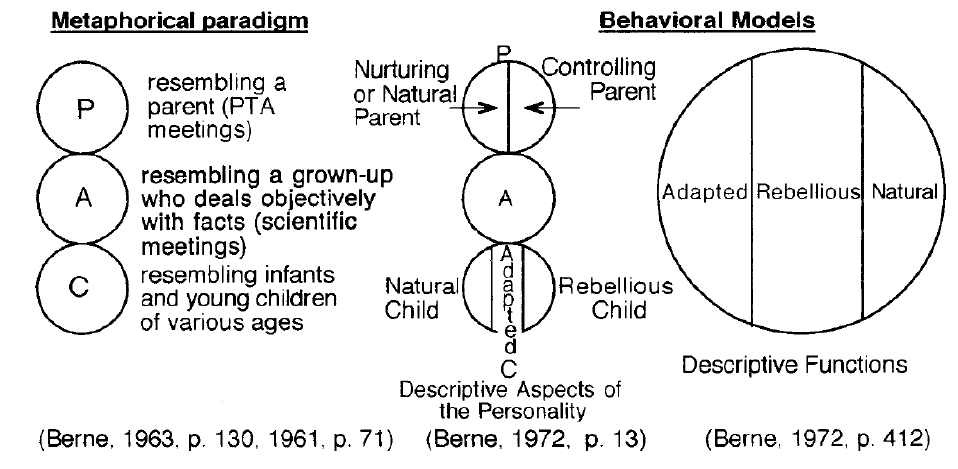
Figure 12: From Metaphorical Paradigm to Behavioural Models (Drego, 1993, p.17)